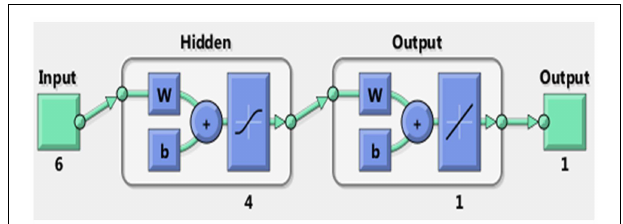
FIGURE 2 | The Artificial Neural Network used for the predictions of apatite compositions and structure parameters. There are six input parameters and one output parameter, one output layer, and one hidden layer. There are 4 neurons used in the hidden layer for the networks.